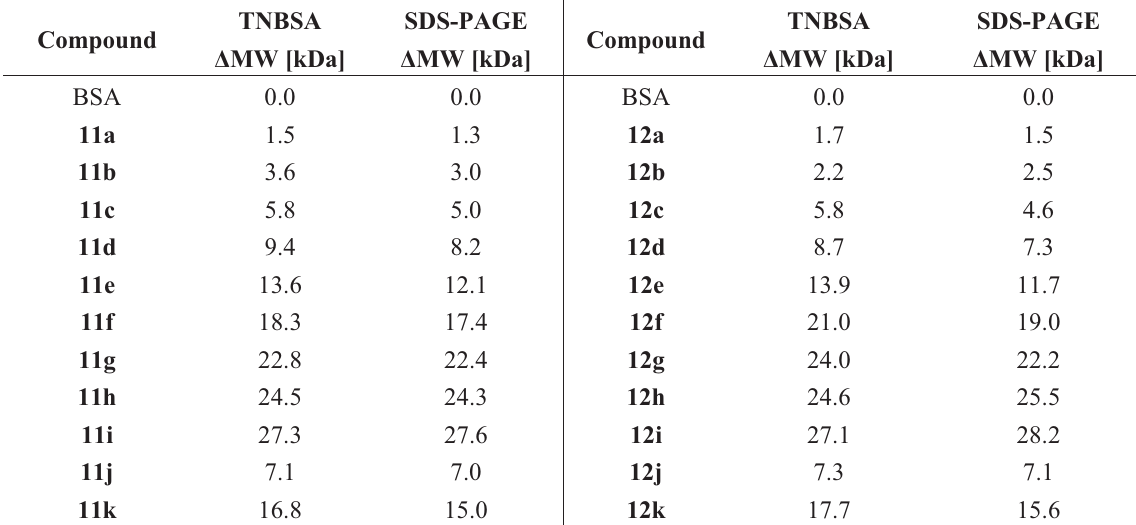
Figure 1. SDS-PAGE analysis of neo-glycoproteins. Electrophoretic mobility of BSA based neo-glycoproteins presenting ( a ) LacNAc-LacNAc ( 11a – k ) and ( b ) LacDiNAc-LacNAc ( 12a – k ) is compared to unmodified BSA (lane C). M—Protein size standard, C—unmodified BSA, 11a – k —LacNAc-LacNAc conjugated BSA (1 μg/lane), 12a – k —LacDiNAc-LacNAc conjugated BSA (1 μg/lane). Table 2. Molecular weight differences ((cid:3)MW) of neo-glycoproteins 11a – k and 12a – k compared to unmodified BSA. Values for retardation factor (R f ) were calculated based on electrophoretic mobility of samples resulting from SDS-PAGE analysis (Figure 1). Measured R f values were transformed to molecular weights by linear regression (y = mx + b; y—log MW; m—slope; x—R f ; b—y-intercept). Differences between the calculated molecular weights of neo-glycoproteins and those of unmodified BSA are compared with data determined by TNBSA